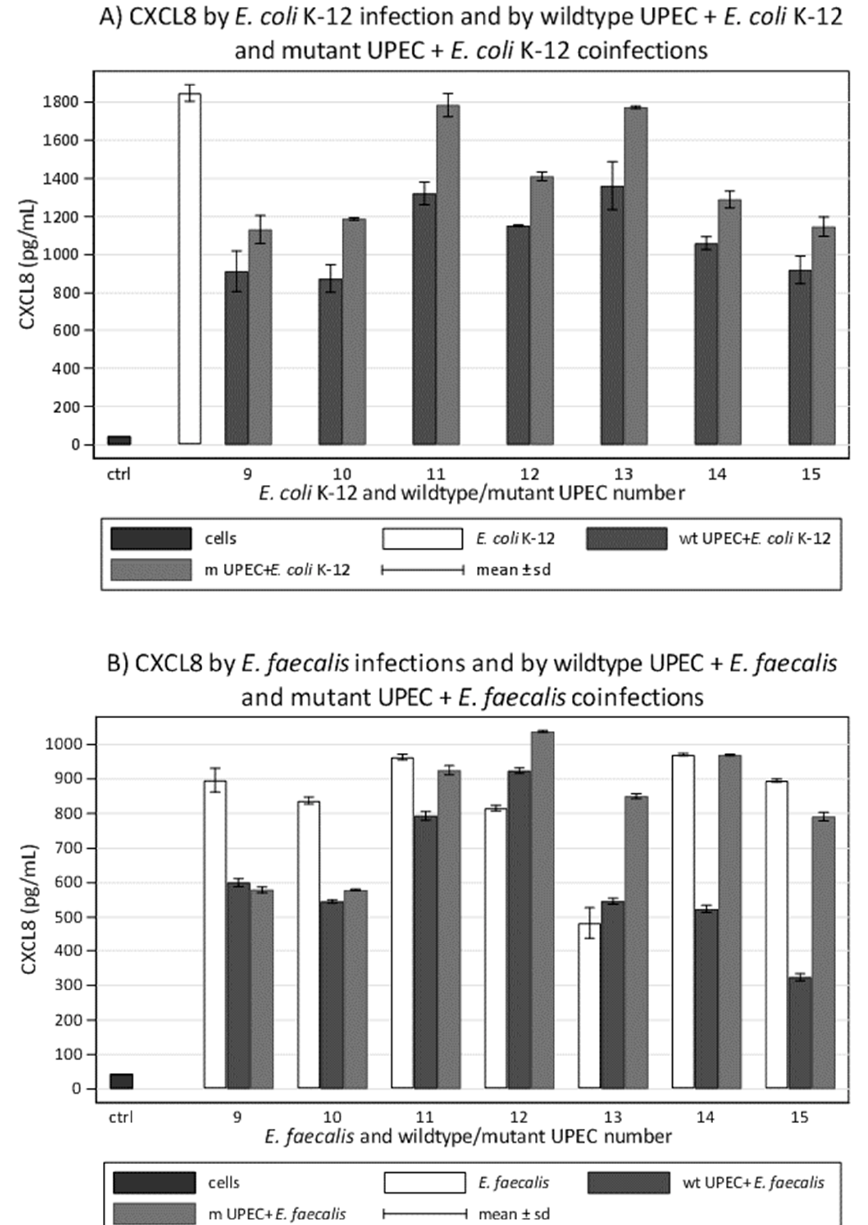
Figure 4. Values of CXCL8 induced in 5637 bladder epithelial cell line by polymicrobial infections with the seven wildtype UPEC and the seven mutant analogues: ( A ) CXCL8 induced by wildtype and mutant UPEC plus the common E. coli K-12 compared to CXCL8 induced by E. coli K-12 alone; ( B ) CXCL8 induced by wildtype and mutant UPEC plus E. faecalis isolated from the same urine compared to CXCL8 induced by E. faecalis alone. wt, wildtype; m, mutant. The results of the in vitro stimulation obtained from seven wildtype UPEC and com- pared with their mutant counterparts showed low p -values for each sign test, which suggests that the mutation has the effect of reducing the difference in each group. However, by applying the Bonferroni correction, only the overall comparison acquires statistical significance (Table